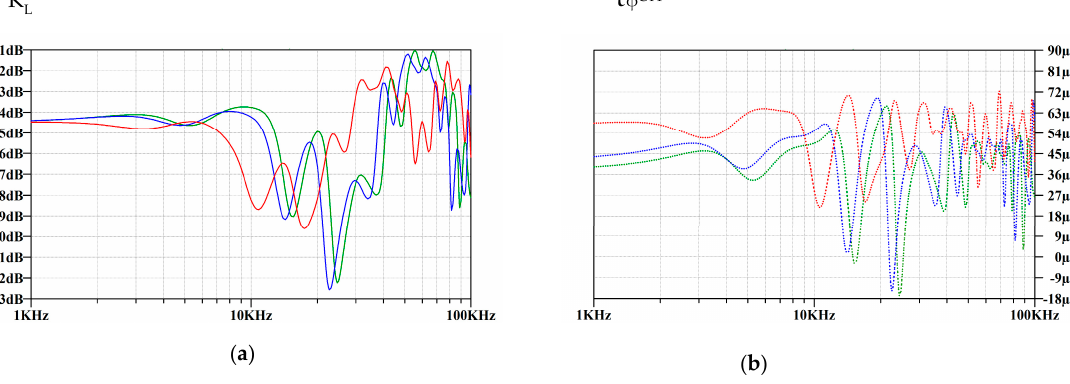
Figure 9. Frequency ( a ) and group delay ( b ) characteristics of the type 1 cable—CT1 (green, 0 T; blue, 5 T; and red, 50 T).